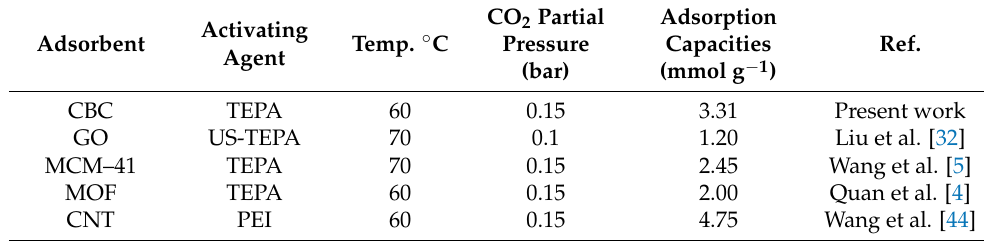
Table 4. Comparison of adsorption capacities of CBC-50-TEPA in past research.